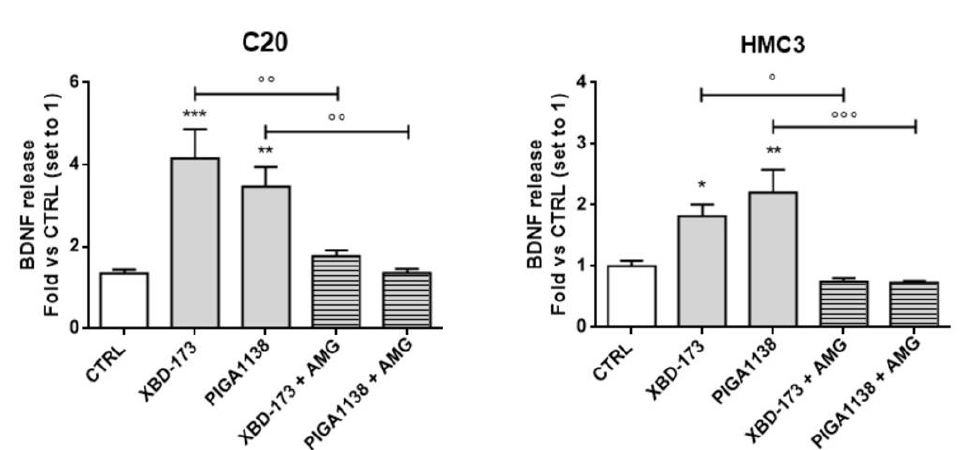
Figure 7. Effects of TSPO pharmacological stimulation on BDNF release from C20 and HMC3 cells. The microglial clones were treated with the potent steroidogenic TSPO ligands XBD-173 and PIGA1138 (100 nM) in serum-free medium for two hours. Then, the medium was replaced and the BDNF release was evaluated after 24 h. To evaluate the potential effect of neurosteroids on BDNF release, C20 and HMC3 cells were exposed to the inhibitor of CYP11A1 AMG (50 µ M) for 1 h before TSPO ligand treatments. The collected medium was used for ELISA, and BDNF concentration was normalized with the number of cells. Data are presented as means ± SEMs of three independent experiments. As shown, the treatment of C20 and HMC3 with XBD-173 or PIGA1138 increased the BDNF production, and the effect was abolished by AMG pre-treatment. Statistical analysis was determined by one-way ANOVA followed by Bonferroni’s post-test: * p < 0.05, ** p < 0.01, *** p < 0.001 vs. control; ◦ p < 0.05, ◦◦ p < 0,01, ◦◦◦ p < 0,001 vs. XBD-173 and PIGA1138.